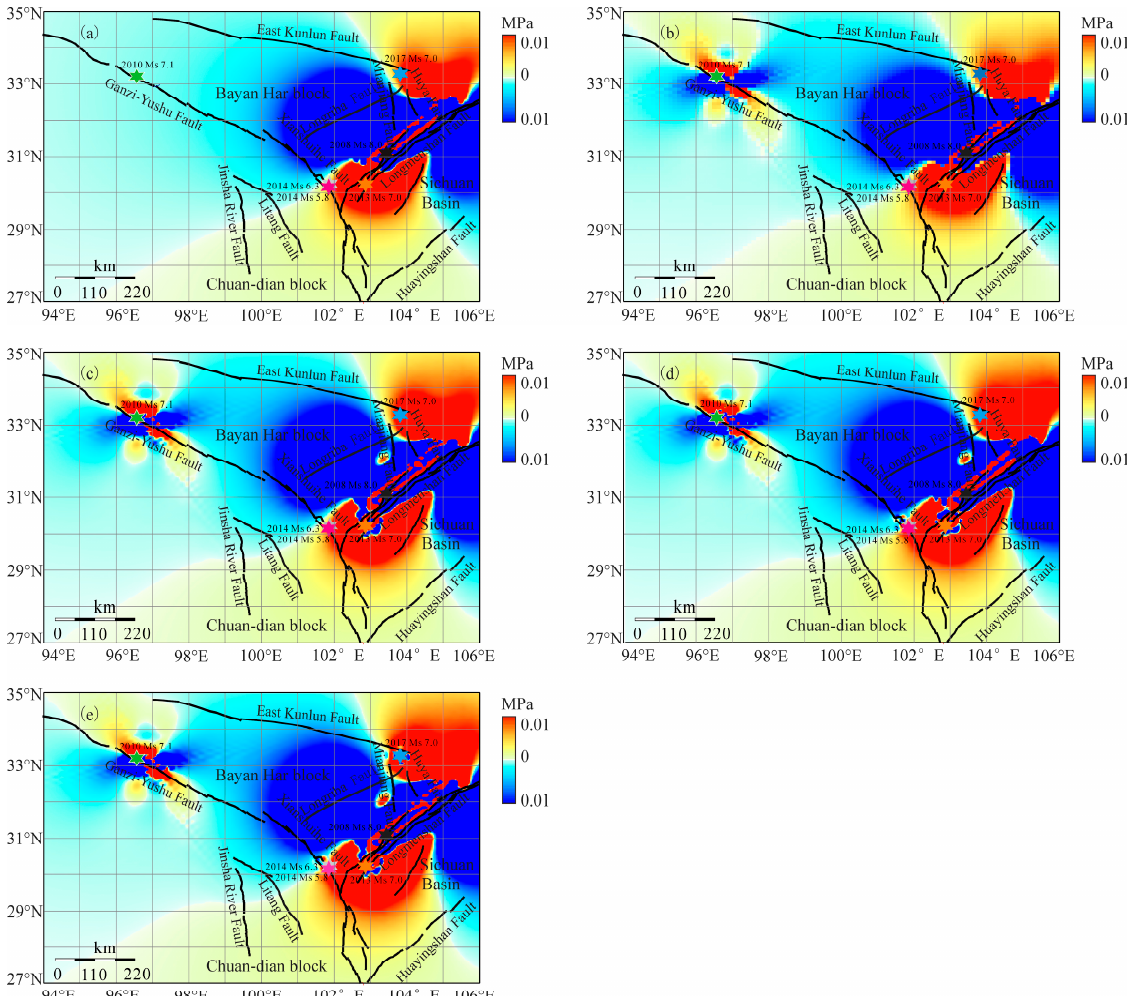
Figure 8. Long-term evolution of stress changes induced by all the previous earthquakes with vis- coelastic relaxation effects and resolved at the depths of the mainshocks with μ ′ = 0.6: ( a ) immediately before the 2010 Ms 7.1 Yushu earthquake, ( b ) immediately after the 2010 Ms 7.1 Yushu earthquake, ( c ) immediately after the 2013 Ms 7.0 Lushan earthquake, ( d ) immediately after the 2014 Ms 5.8 Kangding earthquakes, and ( e ) stress changes calculated on 1 January 2020. The black star indi- cates the epicenter of the 2008 Ms 8.0 Wenchuan earthquake. The green star denotes the 2010 Ms 7.1 Yushu earthquake. The orange star represents the 2013 Ms 7.0 Lushan earthquake. The gray and pink stars indicate the 2014 Ms 6.3 and Ms 5.8 Kangding earthquakes, respectively. The blue star represents the 2017 Ms 7.0 Jiuzhaigou earthquake.